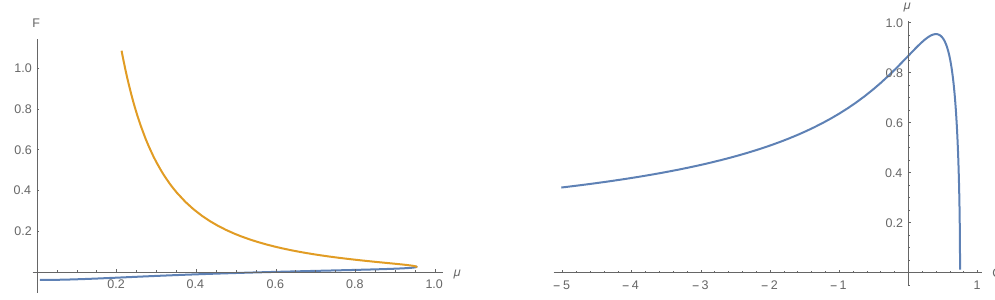
Figure 7 . Left: plot of free energy for the two sets of solutions of holonomy equations. The free energy is exact in (cid:22) , and is plotted for k = 1. Right: plot of (cid:22) versus C . (cid:22) is a single valued function for C = ( (cid:0)1 ; 3